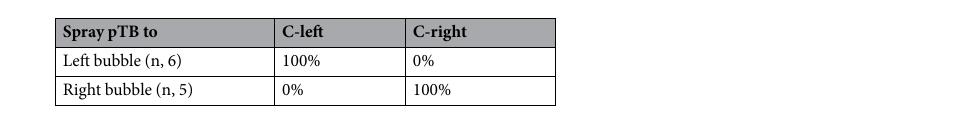
bilayer phase. When low concentration of pTB (50 pM) was applied with the one-bubble administration method, the active channels were inserted into the membrane in the same orientation (Table 1), which can be evaluated by the intrinsic asymmetric activity of the pTB channel 28, 29 (Fig. 2D): Higher conductance was observed at negative